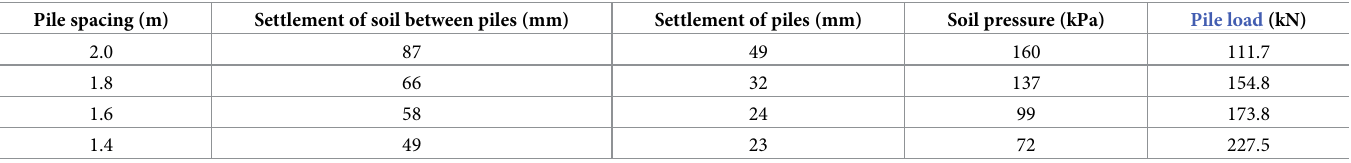
provide a better load sharing outcome compared to GR. The numerical results show that the adjustment of pile spacing and GR stiffness can effectively improve the bearing capacity of soil between piles. ment of soft soil. The stability of the embankment can be assessed by measuring the horizontal displacement of the bottom layer of the Section K58 + 950 using the inclinometer tubes. The measured time-dependent horizontal displacements are summarized in Table 7. The analysis of three-month horizontal displacement of substratum shows that the rate of horizontal dis- placement increment is around 0.12mm/day and the maximum horizontal displacement is around 24mm which is less than the allowable horizontal displacement (i.e. 40mm) [38]. The above analysis indicates that the GRPSE has a significant effect on controlling the dif- ferential settlement of the embankment and adjusting the soil settlement between piles under the embankment. The pile spacing and stiffness of the GR are the most important factors Table 4. Settlements of piles and soil between piles, and soil pressure under different pile spacing. Pile spacing (m) Settlement of soil between piles